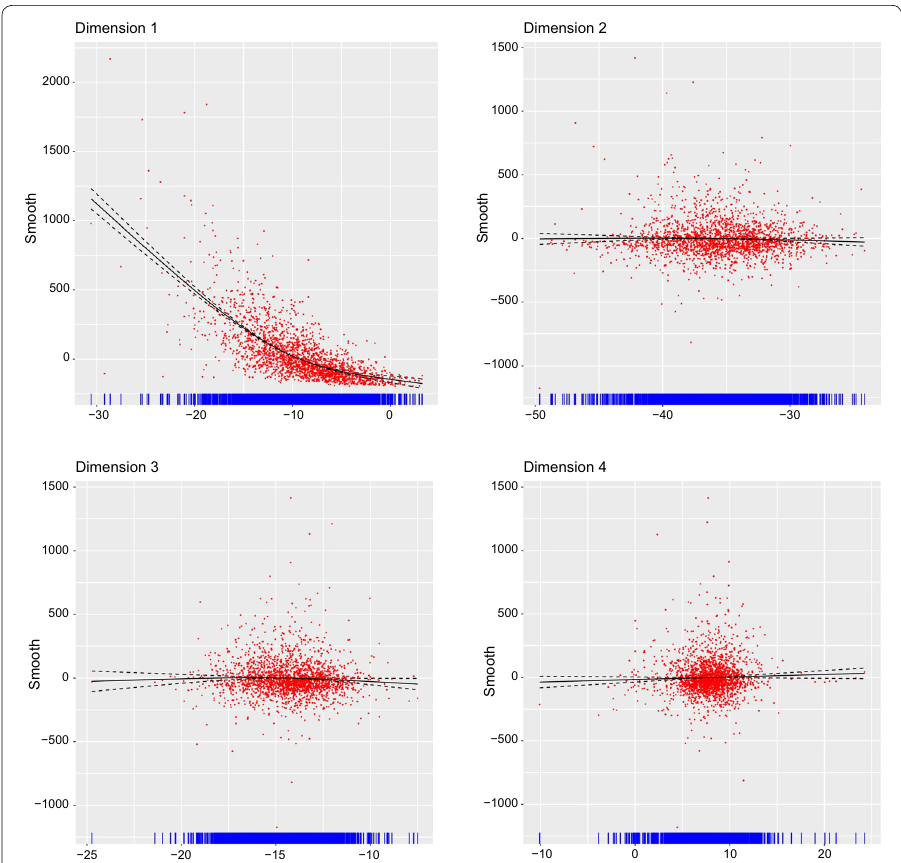
Fig. 3 Partial residual plots for each of the significant SIR predictors when Y 1 is the response